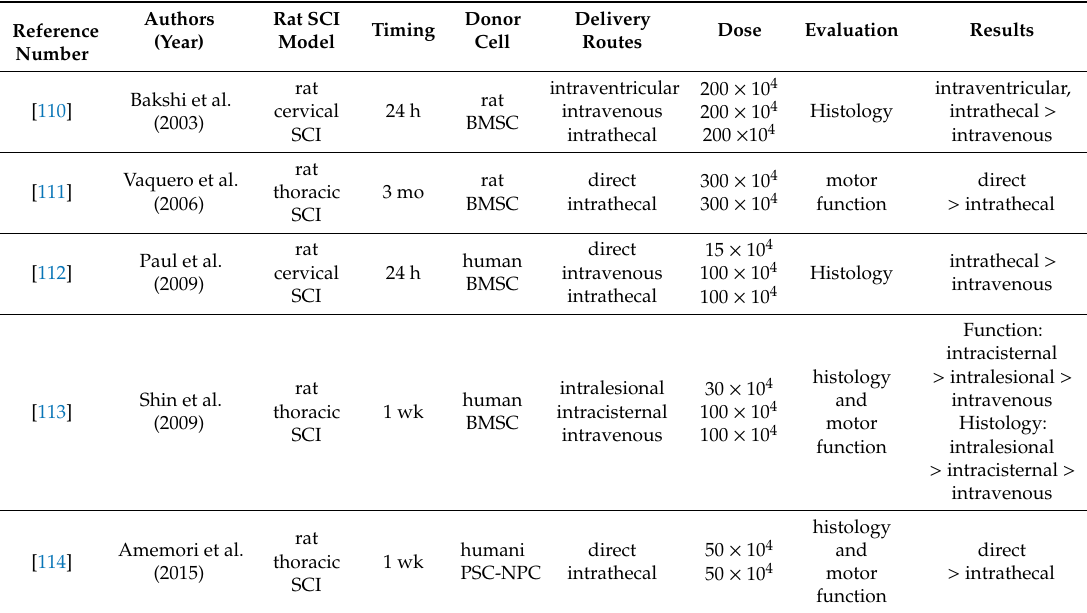
Table 2. Animal experiments comparing the e ffi cacy of di ff erent cell administration